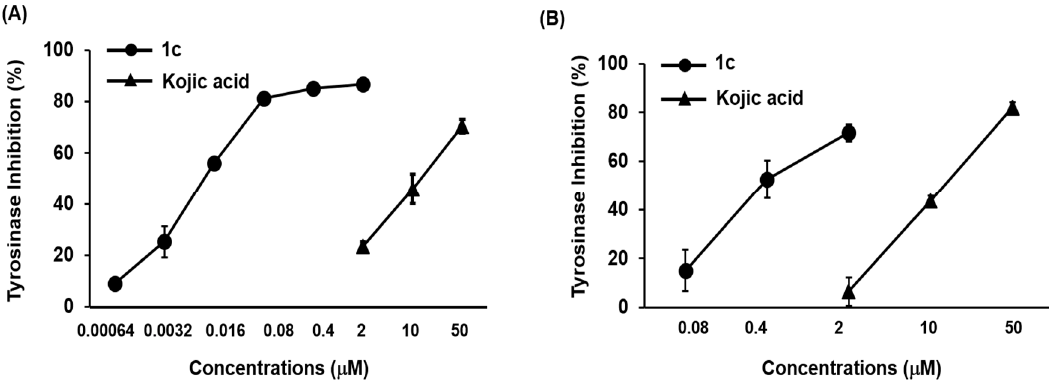
Figure 1. Concentration-dependent inhibitory effects of compound 1c and kojic acid on the activity of tyrosinase for L -tyrosine ( A ) and L -DOPA ( B ) as substrates at 25 °C. The error bar indicates the standard error of the mean (SEM) of triplicate experiments.